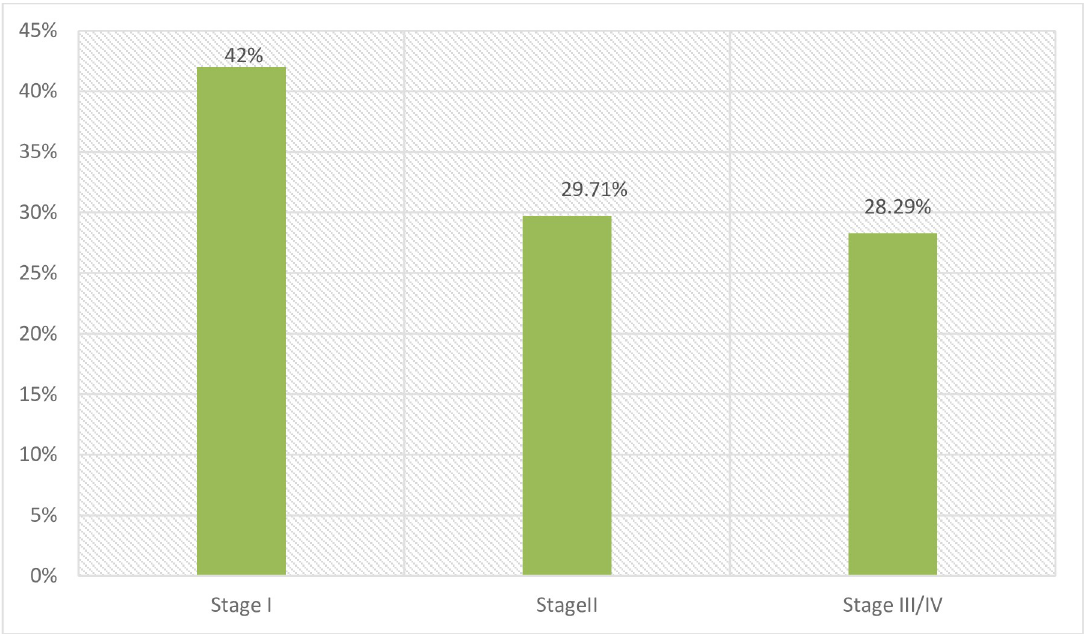
Fig 2. Baseline WHO stage of HIV/AIDS of patients taking ART drugs at ART at public health facilities in South West Shoa Zone, 2019.